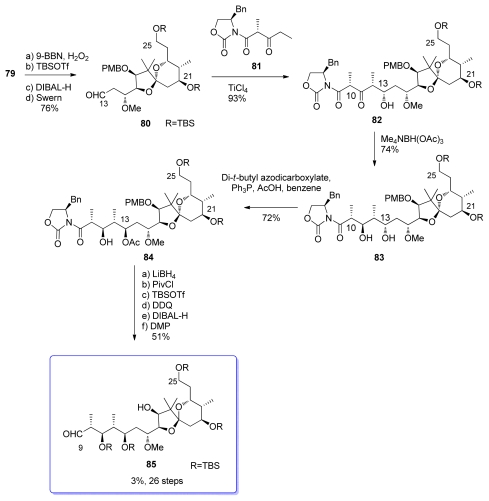
Preparation of 85.